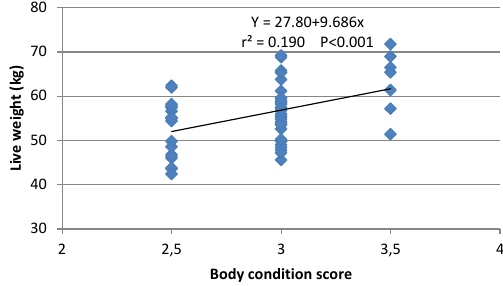
Figure 1. The relationship between body condition score and live